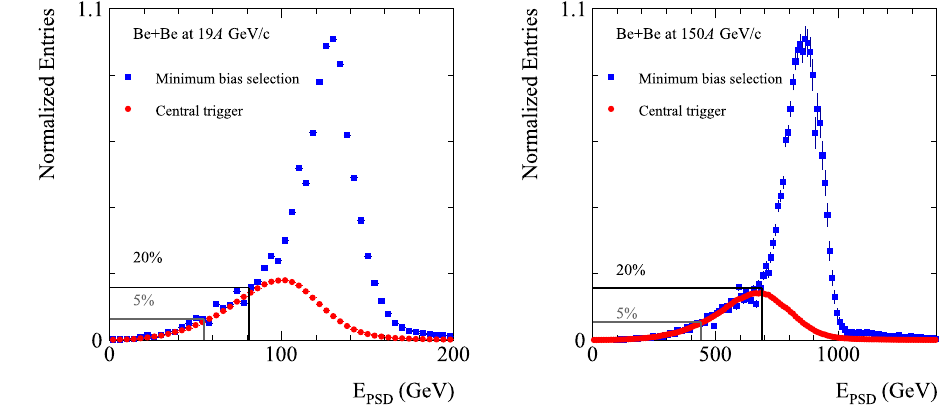
widths of the distributions of W and b . Results Epos WNM are